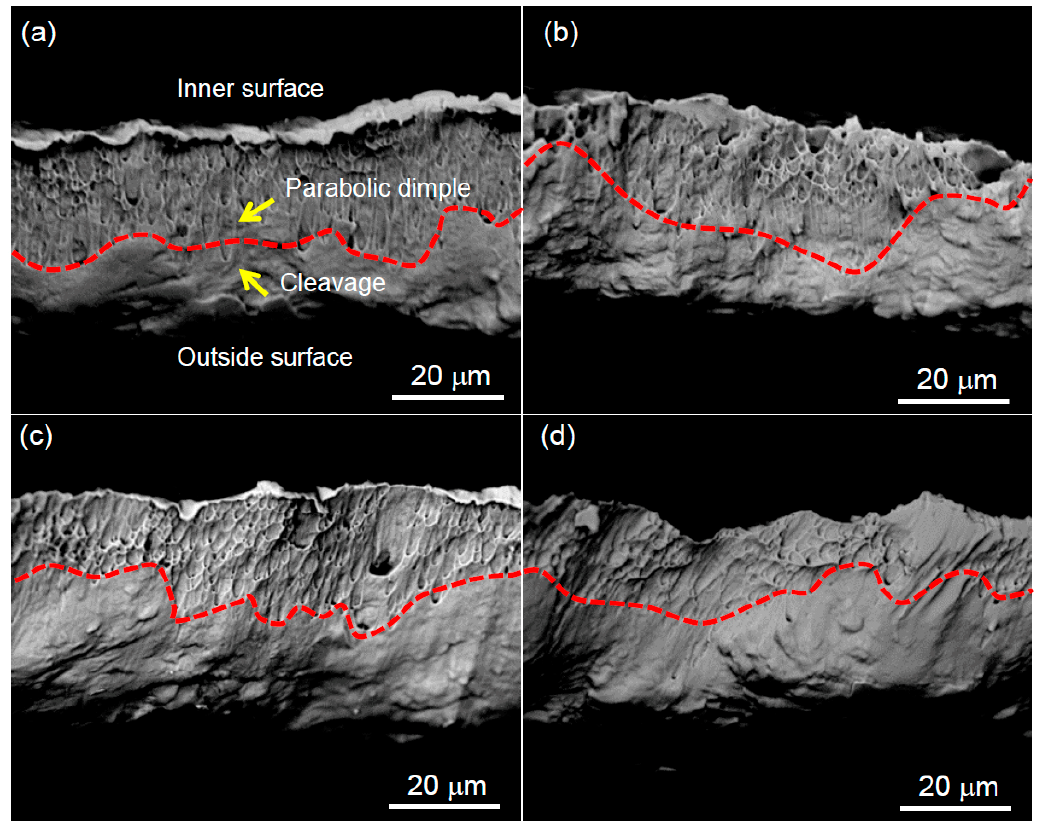
Figure 4. The fracture morphologies of the domed rupture discs at 300 K ( a ), 373 K ( b ), 473 K ( c ) and 573 K ( d ), respectively. Table 2. The physical properties of the 316L austenitic stainless steel [25,26].